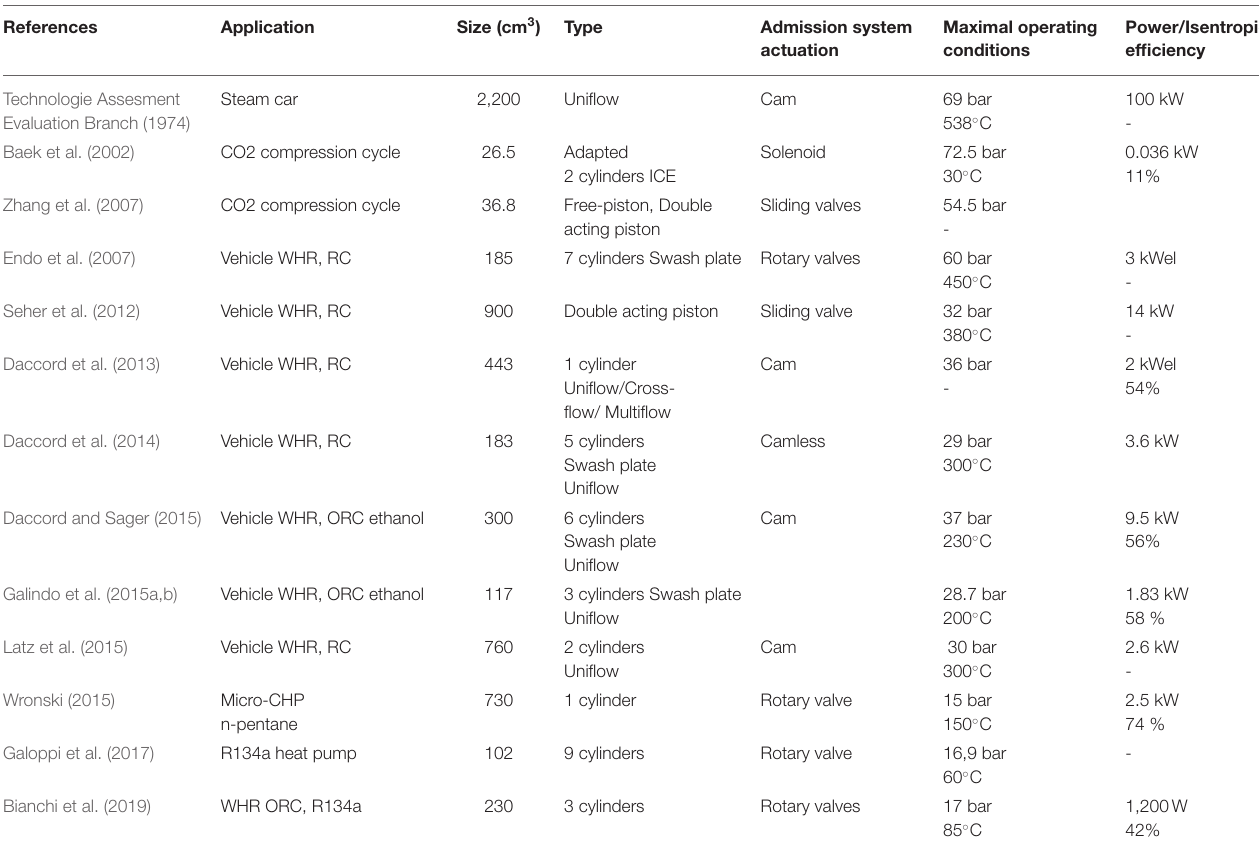
TABLE 1 | Piston expander experimental studies